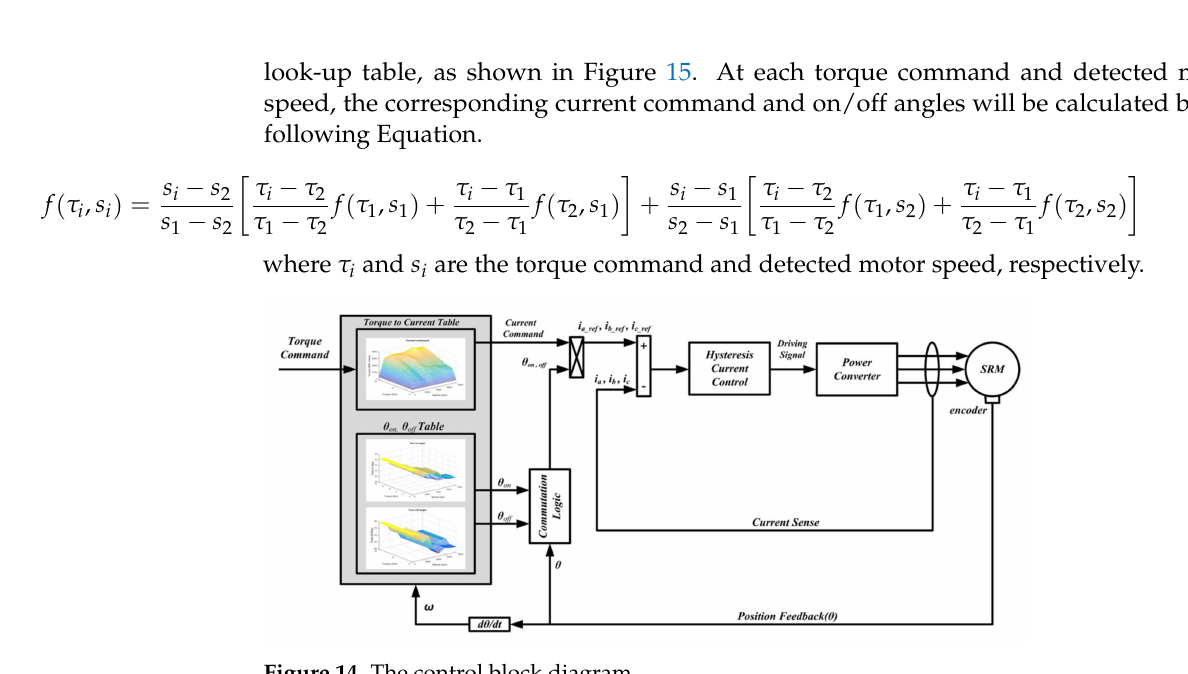
Figure 14. The control block diagram.